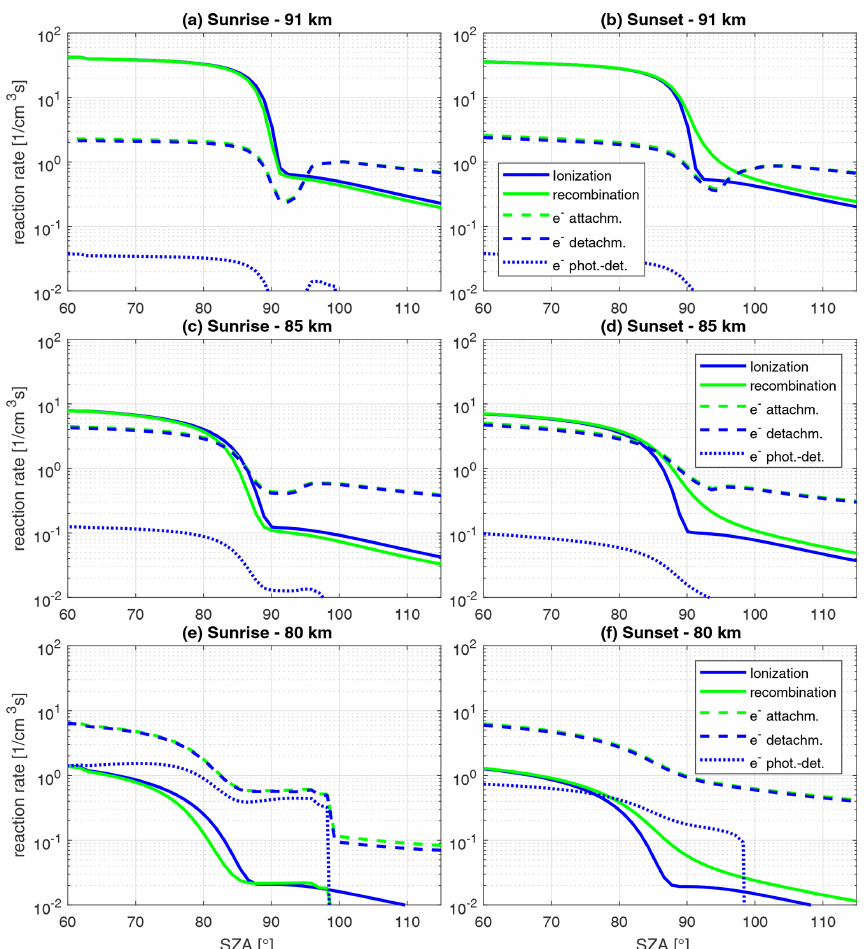
Figure 4. Components of the electron continuity Eq. (1) for altitudes 91km (a, b) , 85km (c, d) , and 80km (e, f) for sunrise (a, c, e) and sunset (b, d, f) . The components are the ionization rate (solid blue), electron–ion recombination rate (solid green), electron attachment to neutrals (dashed green), and electron detachment from negative ions (dashed blue). The latter is the sum of collisional detachment (not shown) and photodetachment of electrons from negative ions (dotted